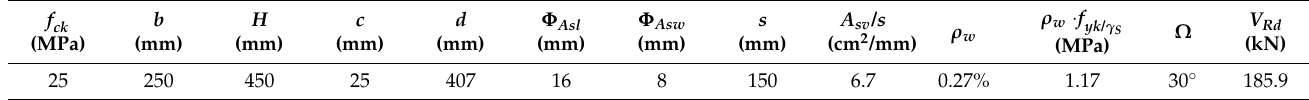
Table 4. Case of design for reliability analysis of shear design of NAC beam with shear